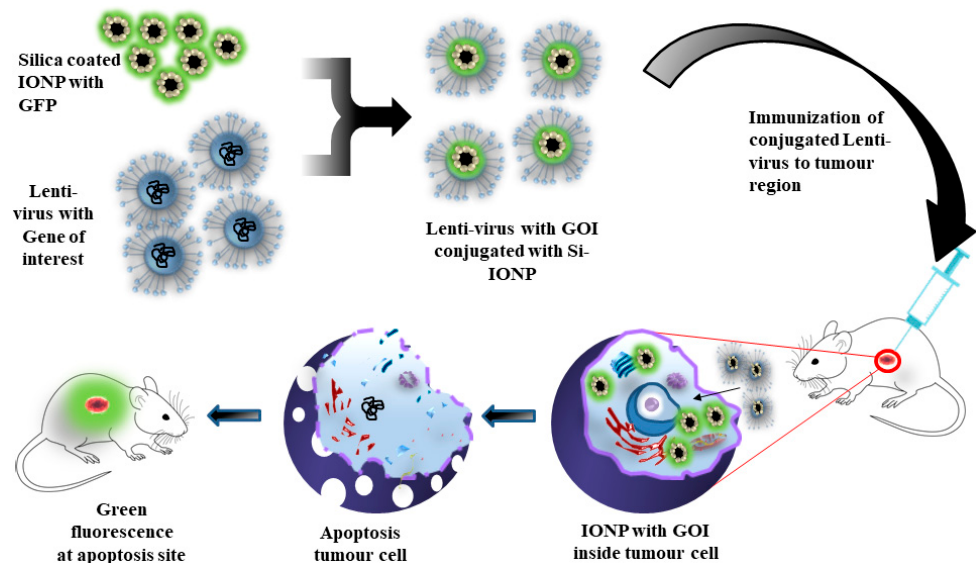
Figure 3. Silica-coated IONPs conjugated with lentiviral vector delivered the gene of interest at the targeted tumor region, and verified via green fluorescence, and cellular apoptosis at the tumor region.